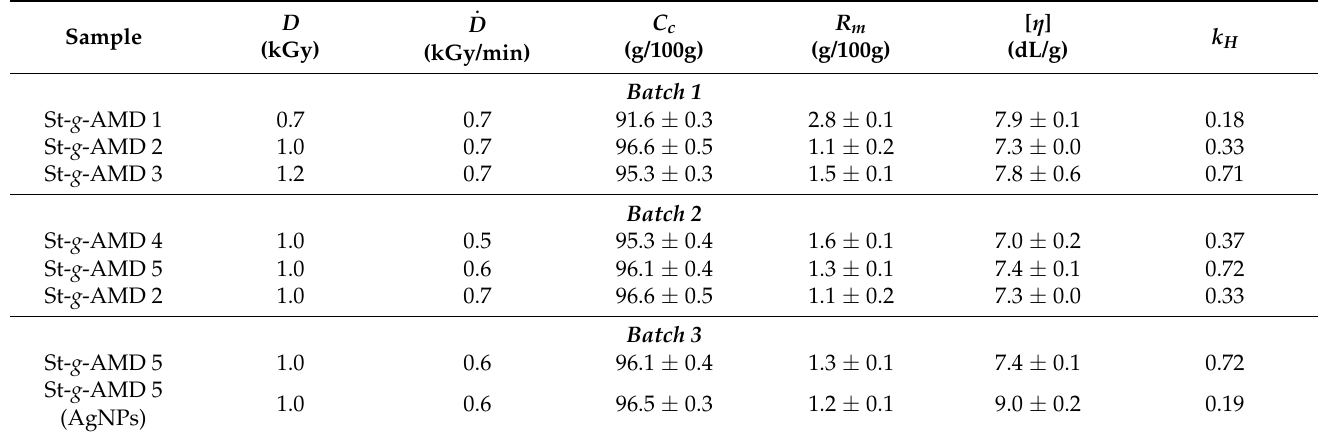
Table 3. Grafting and rheological parameters for graft